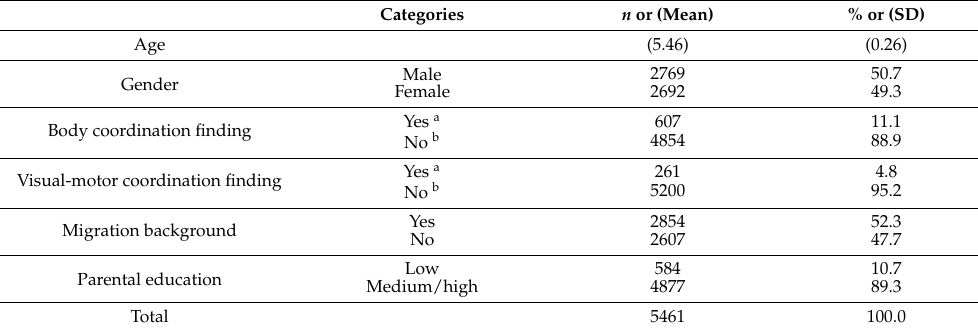
Table 1. Sample Description: Observations ( n ) and Percentages (%) or Mean and Standard Deviation (SD). Categories n or